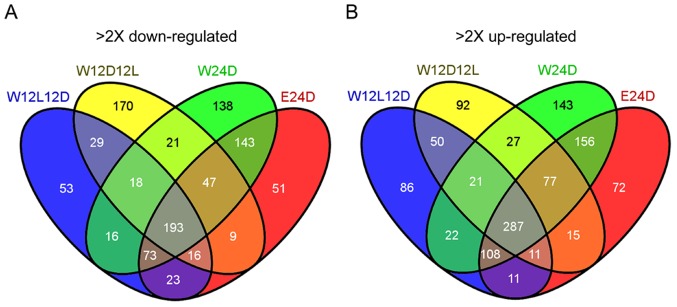
Regulatory targets of sexual potency in the CBS999.97(1–2) wild-type strain (W) and the CBS999.97(1–2) Δenv1 mutant (E).VENN diagram of genes 2-fold downregulated genes (A) and 2-fold up-regulated genes (B) in the four sexually potent conditions (W-24D, W-12L12D, W-12D12L, E24D) in comparison with the four sexually impotent conditions (E24L, E-12L12D, E-12D12L, W-24L). For details on gene regulation see supplementary files (Tables S1 and S2).